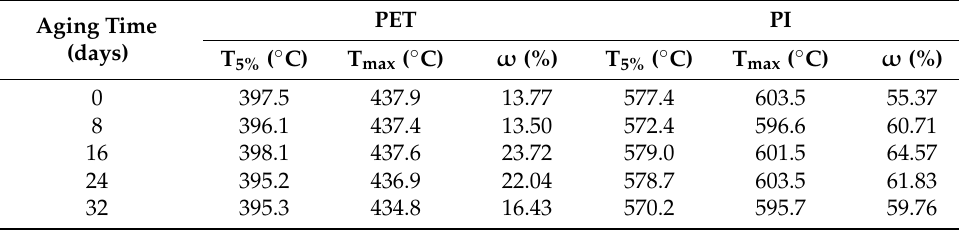
Table 2. Results of TGA measurements for PET and PI films with different aging times a .